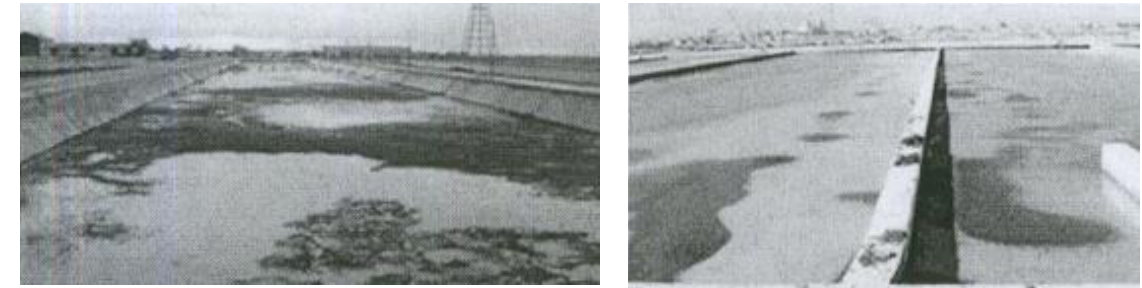
Fig. 4. A drying bed’s incapacity in cold (left) and rainy (right) conditions (Moradhasseli,